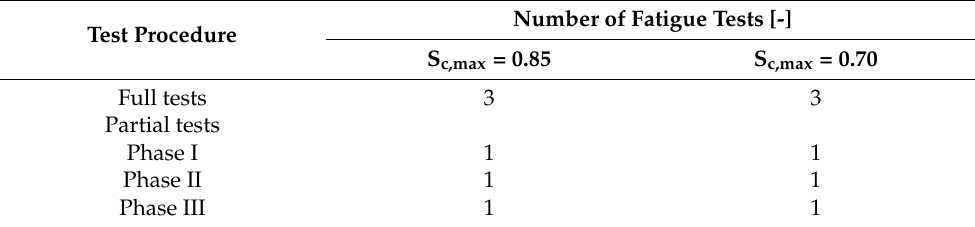
Table 2. Number of fatigue tests analysed (full and partial tests).